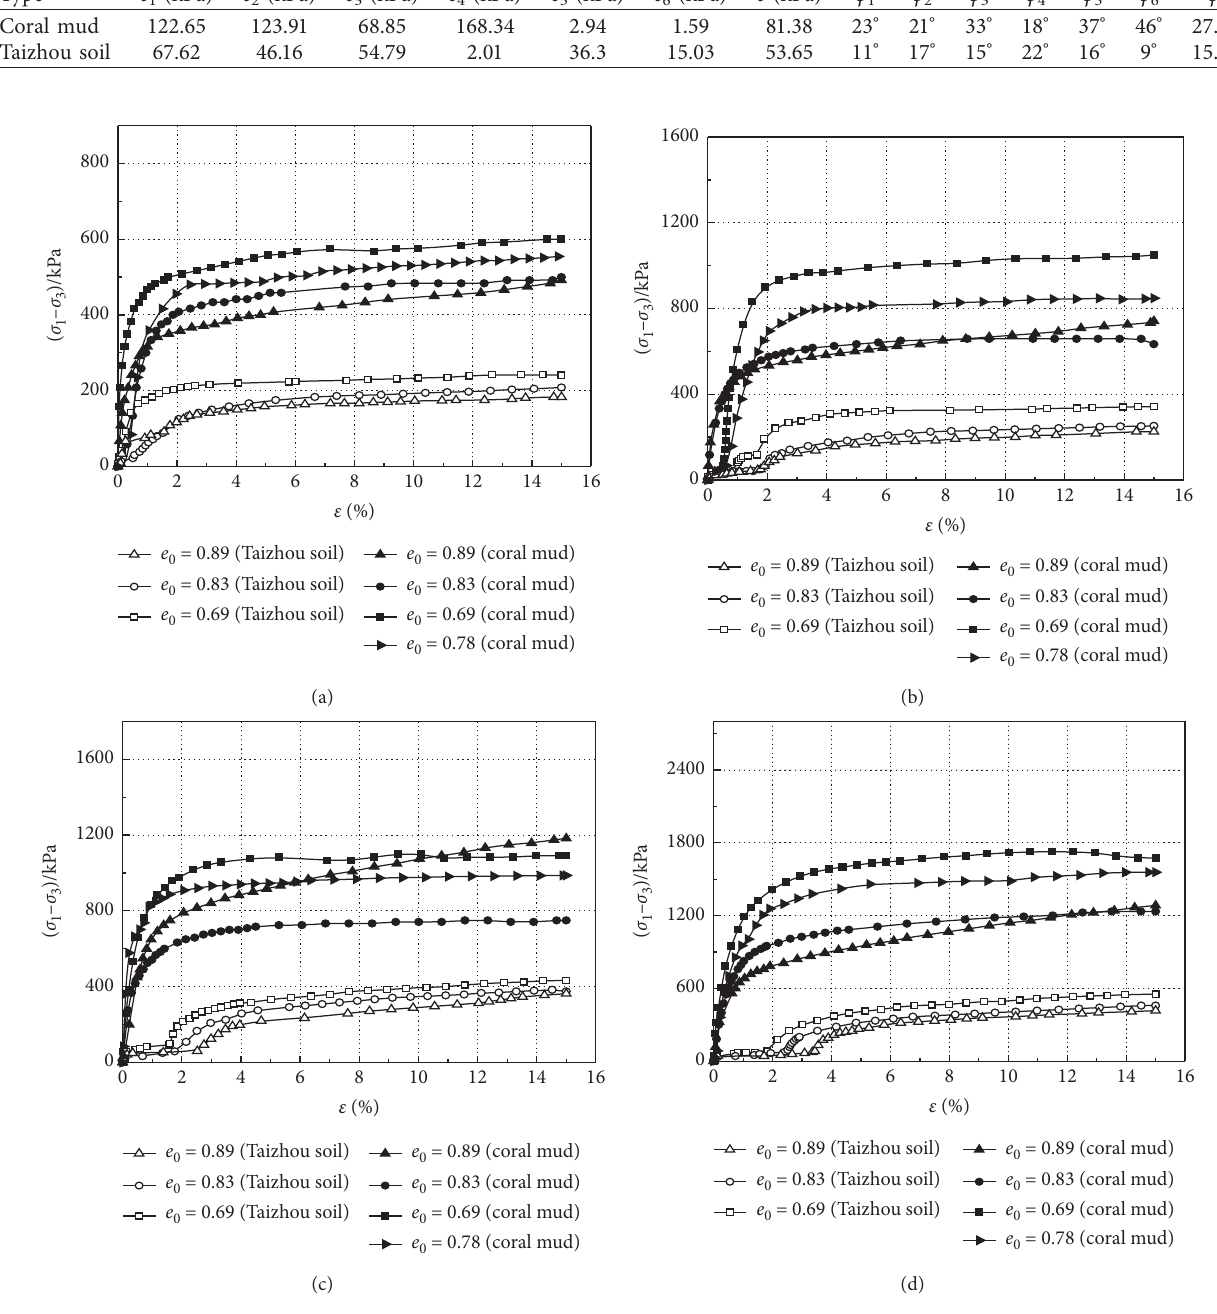
Figure 6: Stress-strain behaviour at different initial void ratios: (a) 100kPa, (b) 200kPa, (c) 300kPa, and (d) 400 kPa.